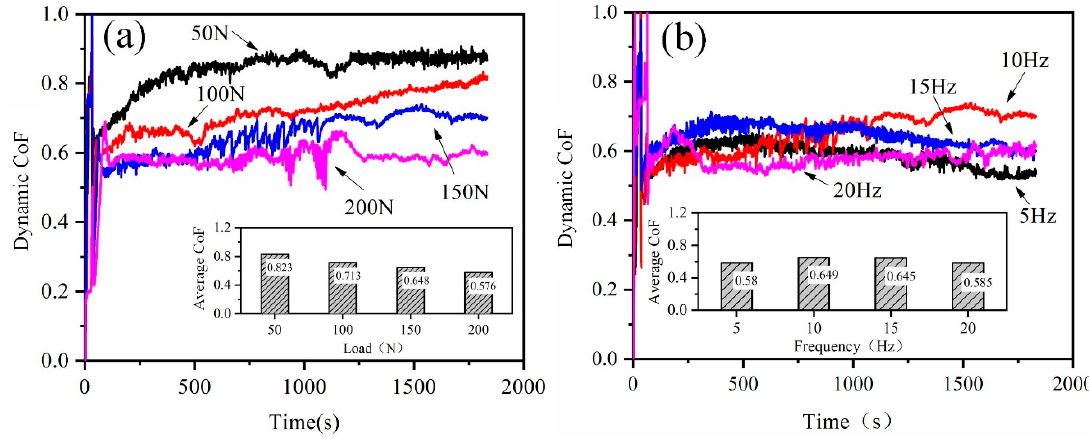
Figure 9. The CoF of tribo-pairs under different: ( a ) loads and ( b ) reciprocating frequencies.